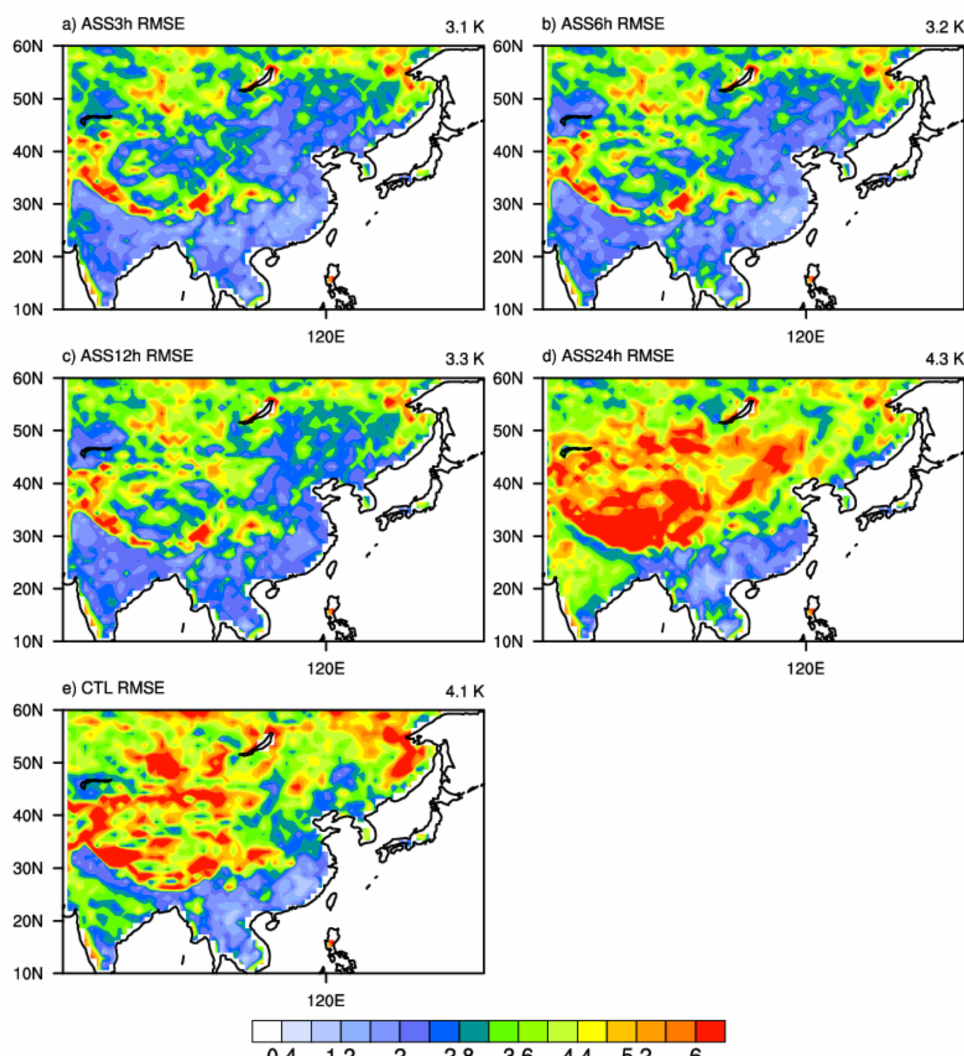
Figure 9. Same as in the Figure 8 but for the nighttime